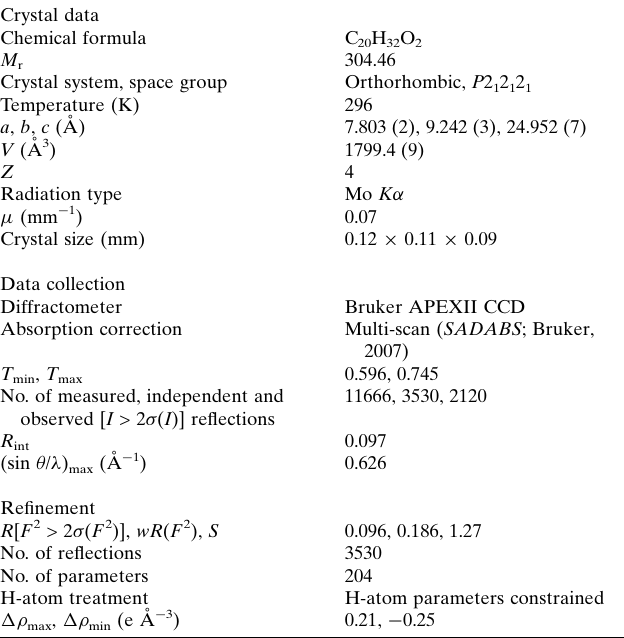
Table 2 Experimental